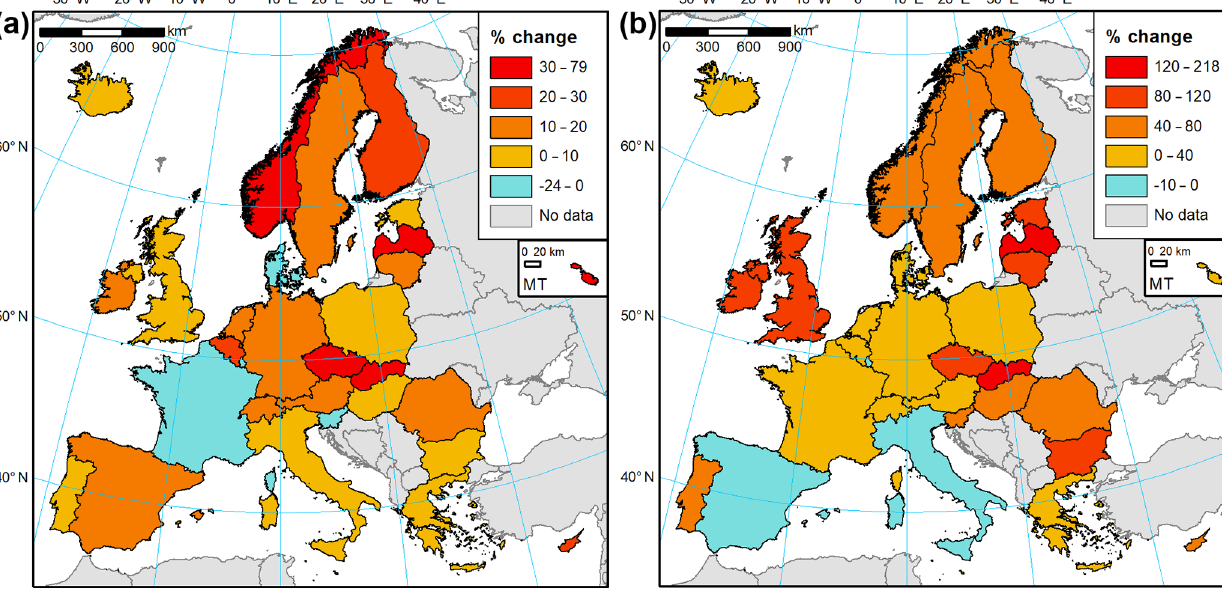
Figure 6. Change in the value of (a) residential buildings and (b) household contents per square metre of floor space, 2000–2017, in constant prices. Country boundaries from EuroGeographics (Eurostat,